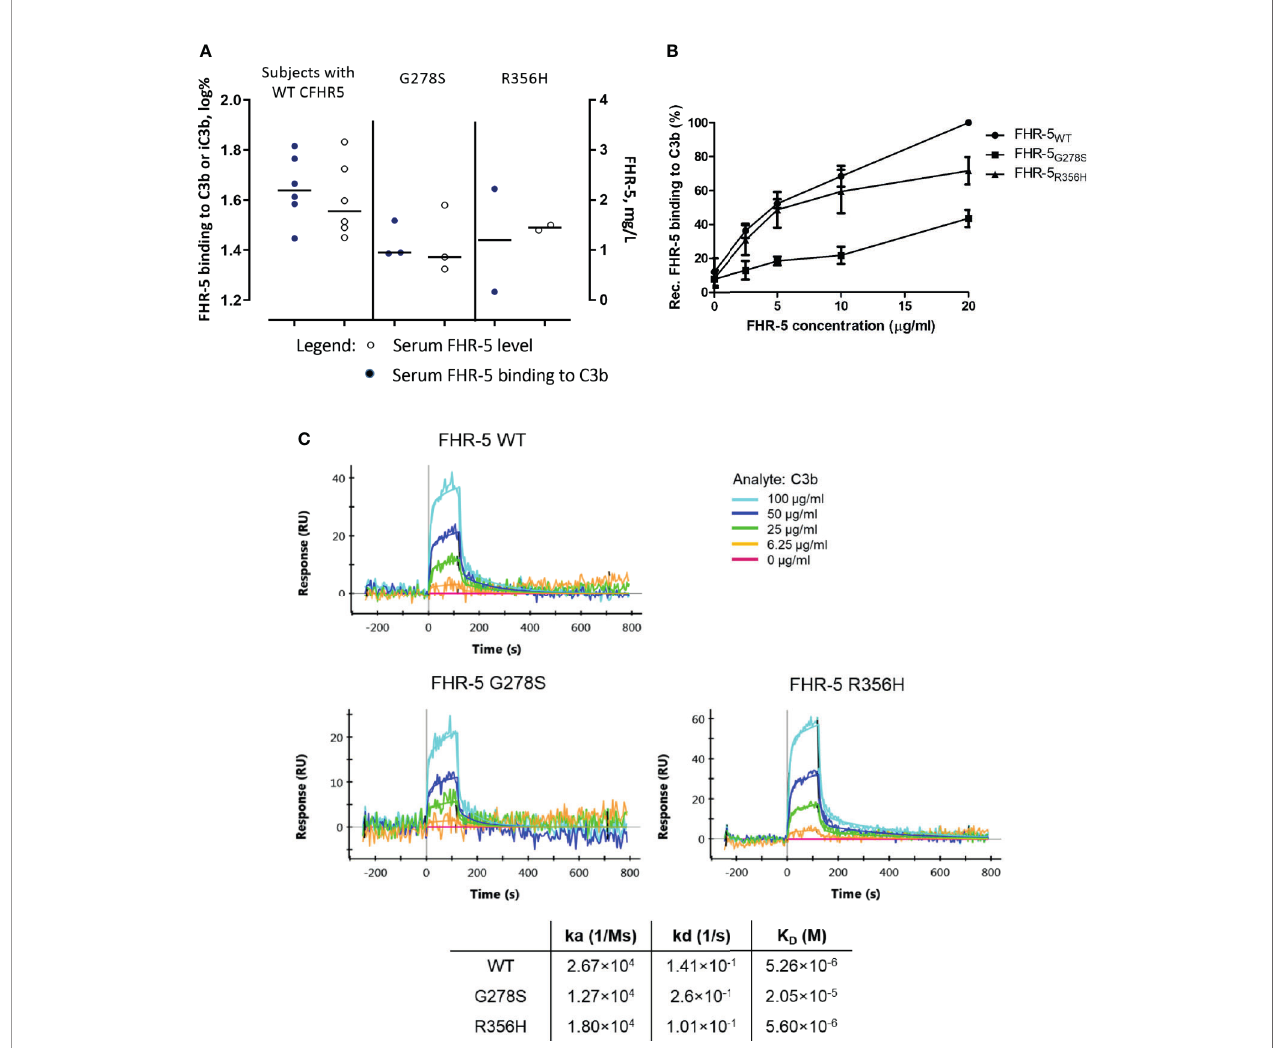
FIGURE 4 | (A) Comparison of serum Factor H-related protein 5 (FHR-5) levels and serum FHR-5 C3b-binding ability of patients with only FHR-5 WT and those carrying FHR-5 G278S or FHR-5 R356H in ELISA. C3b was immobilized, then serum was added, and FHR-5 was detected by polyclonal anti-FHR-5. Dots represent individual patients. Data are mean of two measurements and are normalized to a calibrator sample containing only FHR-5 WT . Subjects expressing FHR-5G278S show a tendency of lower FHR-5 levels and decreased C3b binding compared to the FHR-5WT-expressing group. Serum FHR-5 levels were measured in a sandwich ELISA. Circles represent individual patients. Data are mean of two measurements. (B) Dose-dependent binding of recombinant FHR-5 WT , FHR-5 G278S , and FHR-5 R356H to puri fi ed C3b measured in ELISA. The FHR-5 G278S variant binds signi fi cantly weaker to C3b (one-way ANOVA with Bonferroni ’ s posttest, p < 0.01). Data are mean of four measurements ± SEM. (C) Interaction of C3b – FHR-5 variants measured by surface plasmon resonance (SPR). C3b in serial dilutions was – FHR-5 – FHR-5 – FHR-5 fl own over immobilized FHR-5 variants. The K D of the C3b G278S is one order greater compared to that of C3b R356H and C3b WT . Data are representative of two